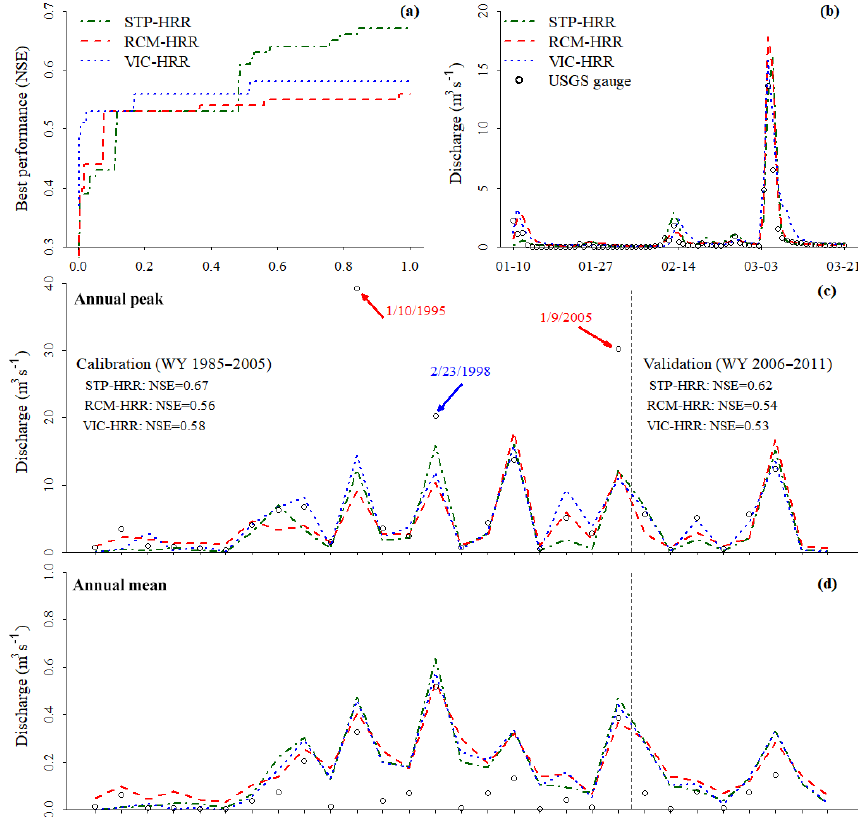
Figure 3. Model performance for calibration and validation periods: (a) model performance (assessed by NSE) during the calibration process; the x axis is the normalized calibration process; the “normalized calibration process” means the x axis range is normalized by the number of iterations during calibration; (b) hydrographs simulated by three calibrated models and measured by the USGS gauge; in order to show the details of the hydrographs, they are zoomed in to the wet season in 2001; the model performance is similar in other years; (c) simulated annual peak flow during calibration (water year 1985–2005) and validation (water year 2006–2011) periods as compared with in situ observations; black texts indicate model performance (i.e., NSE); the points highlighted in red arrows indicate the events were not reproduced by models due to the input (e.g., precipitation or discharge observation) bias; the point highlighted in blue arrow is similar to those in red but at a lower probability; and (d) simulated and observed annual mean flow during calibration and validation periods. For clarity, only results for the Mission Creek watershed (USGS gauge no. 11119750) are shown here; results for other gauged watersheds are similar and can be found in the Supplement (Figs.